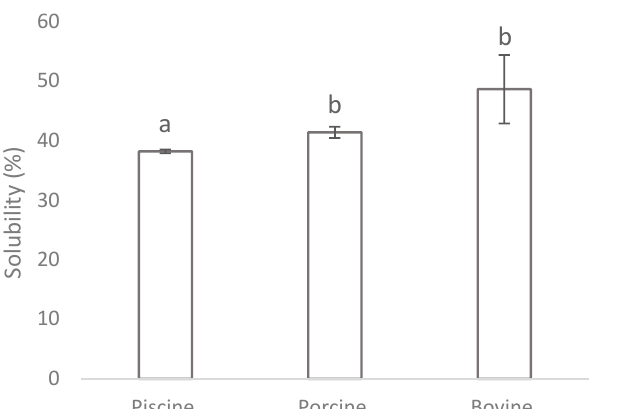
Figure 2. Solubility in water of bioplastics generated from porcine, piscine, and bovine gelatine. Values represent an average of n = 3; error bars represent standard deviation with different lowercase letters representing significantly different values.